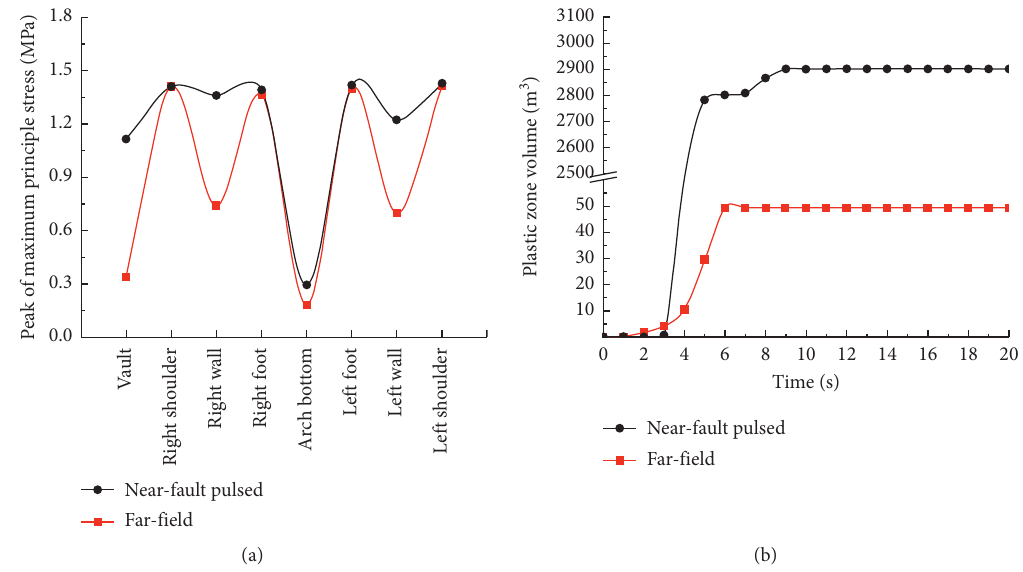
Figure 5: The comparison of the principal stress of the structure and the plastic failure zone of the model under different ground motions. (a) The principal stress of the tunnel structure. (b) The plastic failure zone volume of the tunnel